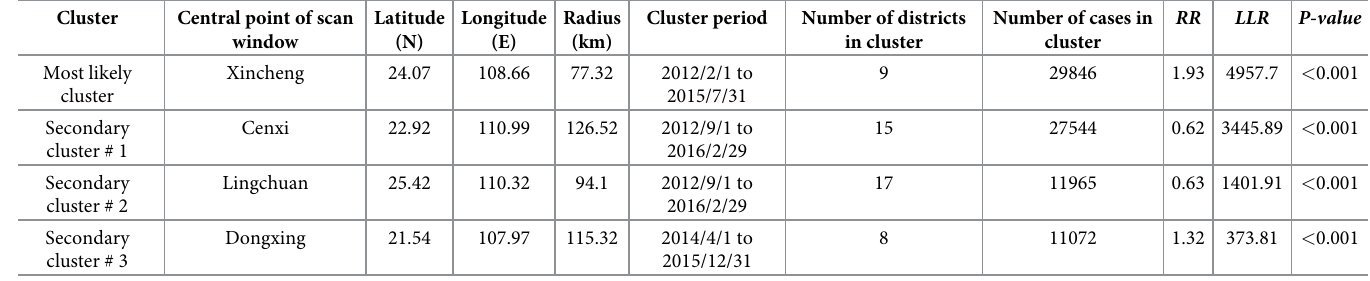
Table 4. Space-time clusters of tuberculosis cases in Guangxi from 2010 to 2016.